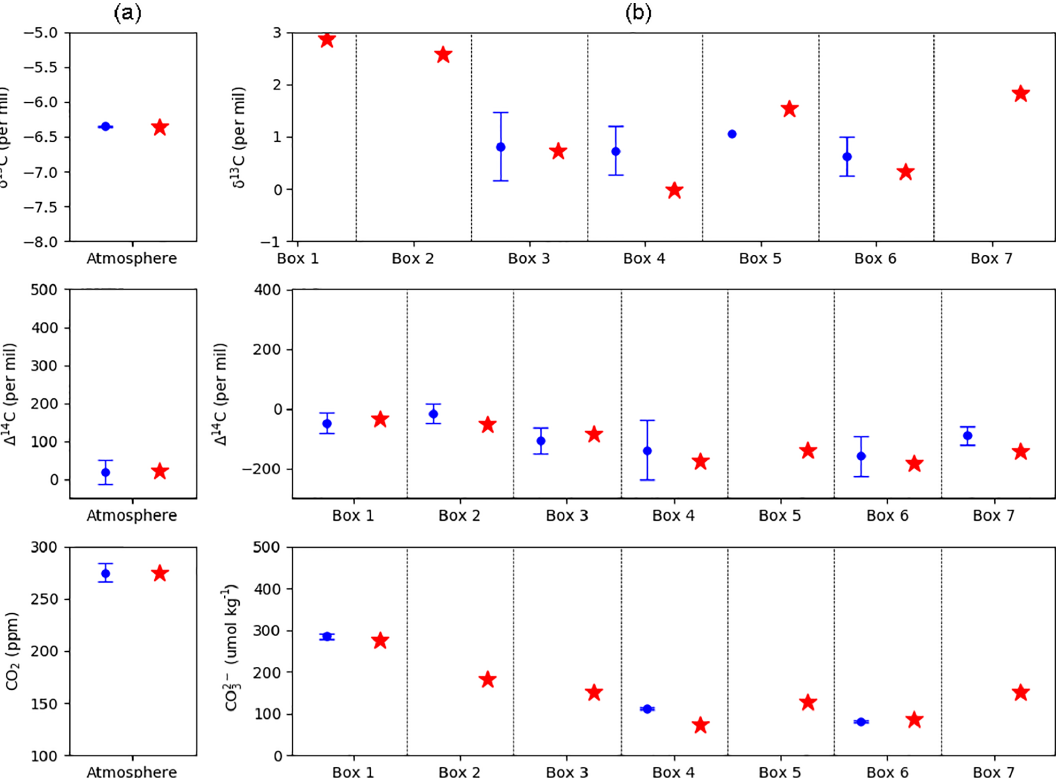
Figure 3. SCP-M late-Holocene-calibrated model results using model input parameters from the literature (Table A1). (a) Model results for atmospheric δ 13 C, (cid:49) 14 C and CO 2 (red stars) plotted against late Holocene average data values (blue dots) with standard error bars. (b) The model results for oceanic δ 13 C, (cid:49) 14 C and the carbonate ion proxy (red stars) plotted against late Holocene average ocean data where available (blue dots). Data sources are shown in Table